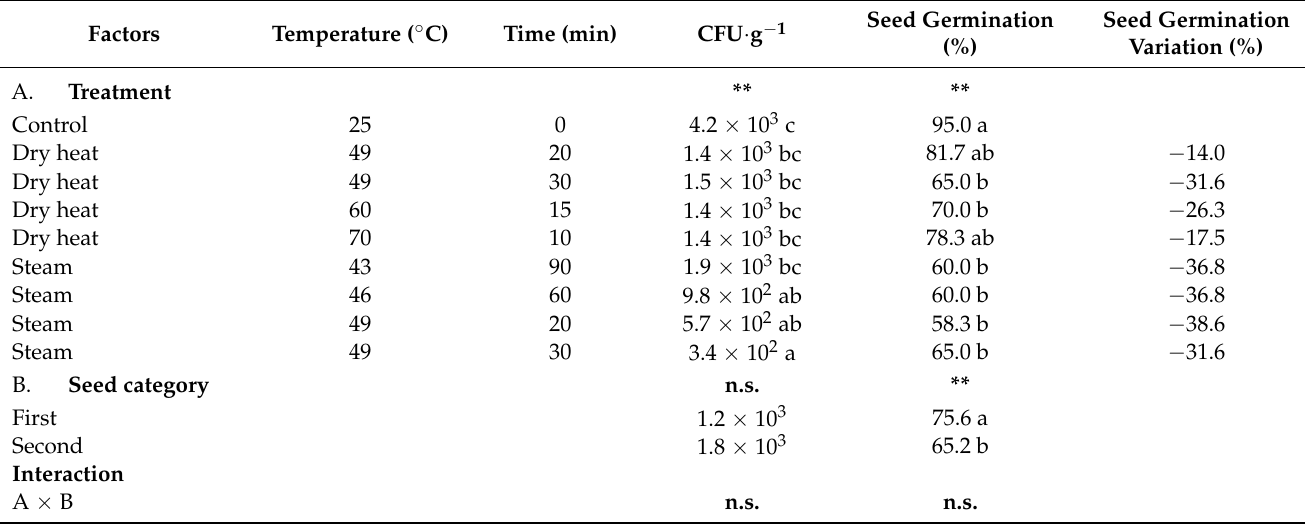
Table 3. Analysis of variance of CFU · g − 1 and seed germination (%) at the end of the first experiment with high temperatures. Dry heat and steam were applied to garlic cloves divided in the two quality categories (first category cloves length > 15 mm, second category 10–15 mm clove length). Different letters indicate significant differences according to Tukey’s test ( p <